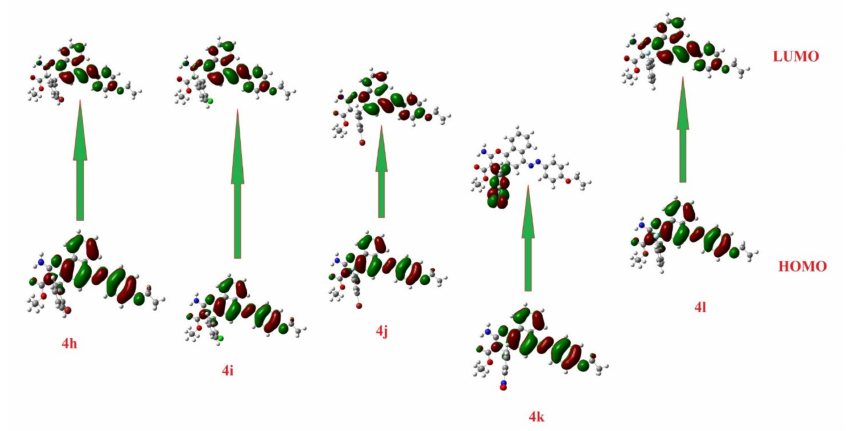
Figure 5. Molecular orbital spatial distribution and localization for the HOMO and LUMO of 4h-l